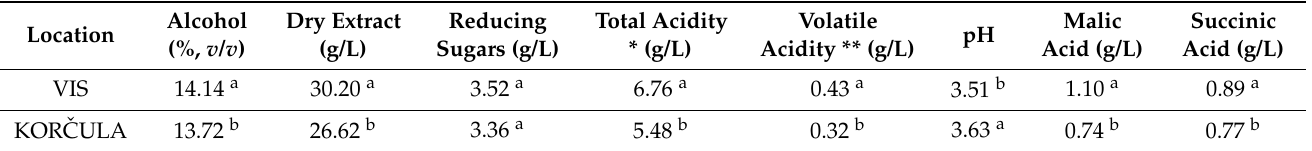
Table 3. Physicochemical properties of Plavac mali wines according to grape growing location.